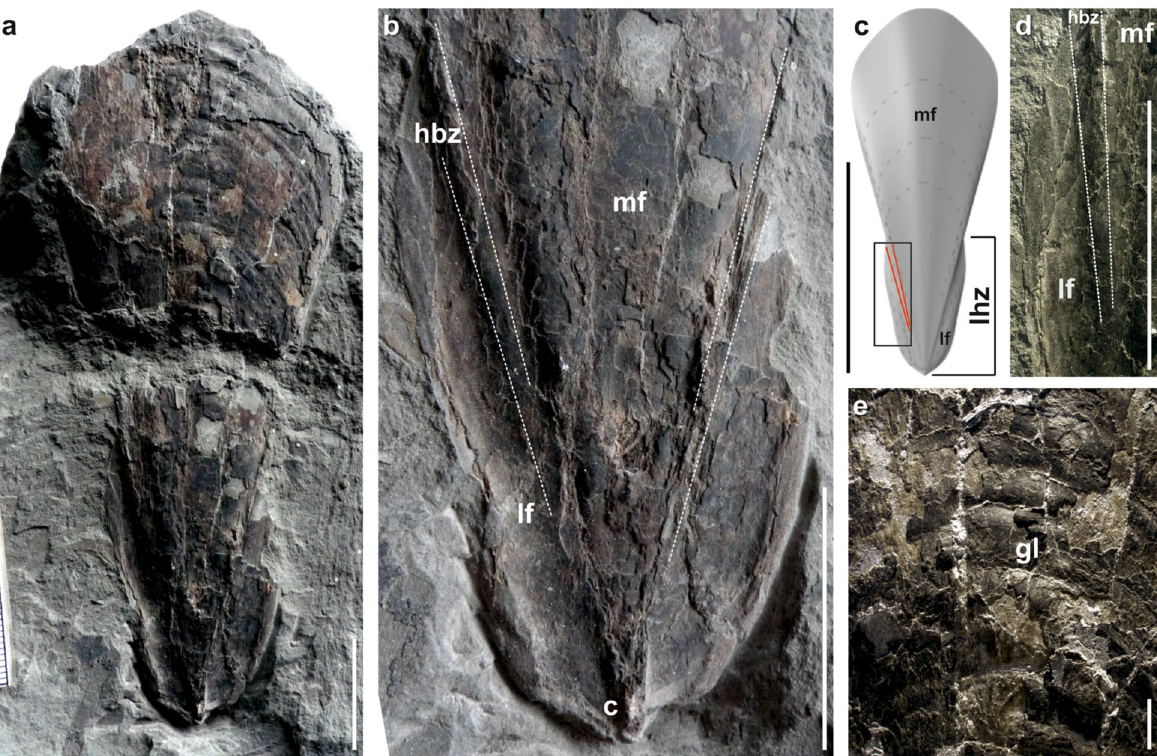
Fig. 1 Gladius of N. hungarica Kretzoi, 1942 (holotype — specimen no. M59/4672 Hungarian Natural History Museum). a Nearly complete gladius, dorsal view, scale bar = 2 cm. b Detail of the apical part forming conus (c), mf median fi eld, lf lateral fi elds, hbz hyperbolar zones, dashed lines mark the hyperbolar zones separating lateral fi elds from the median fi eld, scale bar = 2 cm. c Reconstruction of the gladius, red lines demarcate hyperbolar zones, mf enlarged median fi eld, lhf length of hyperbolar zones, scale bar = 10 cm, rectangle shows the postion of the d , scale bar = 2 cm. d Detail of the lateral fi eld with hyperbolar zone and median fi eld, scale bar = 2 cm. e Detail of the median fi eld with marked concentric growth lines